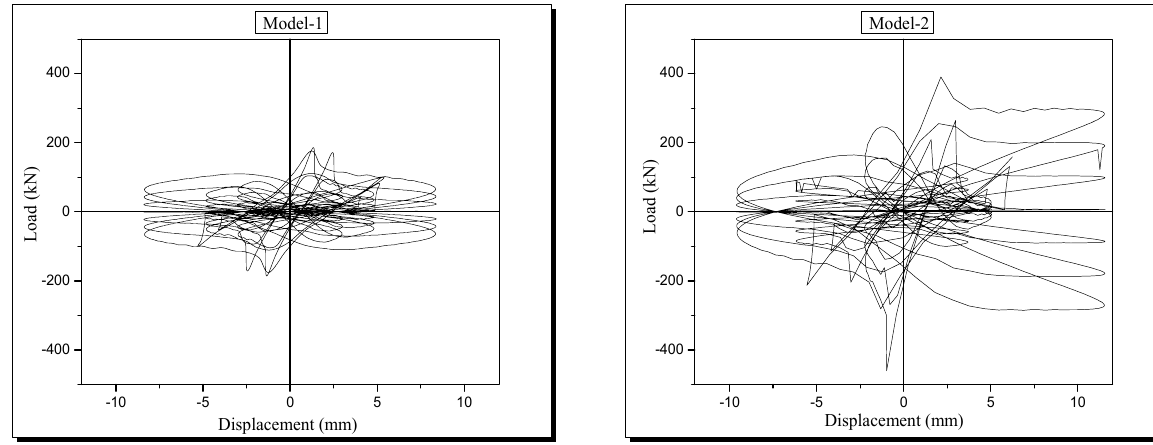
Figure 4: Load Vs displacement on timber beam